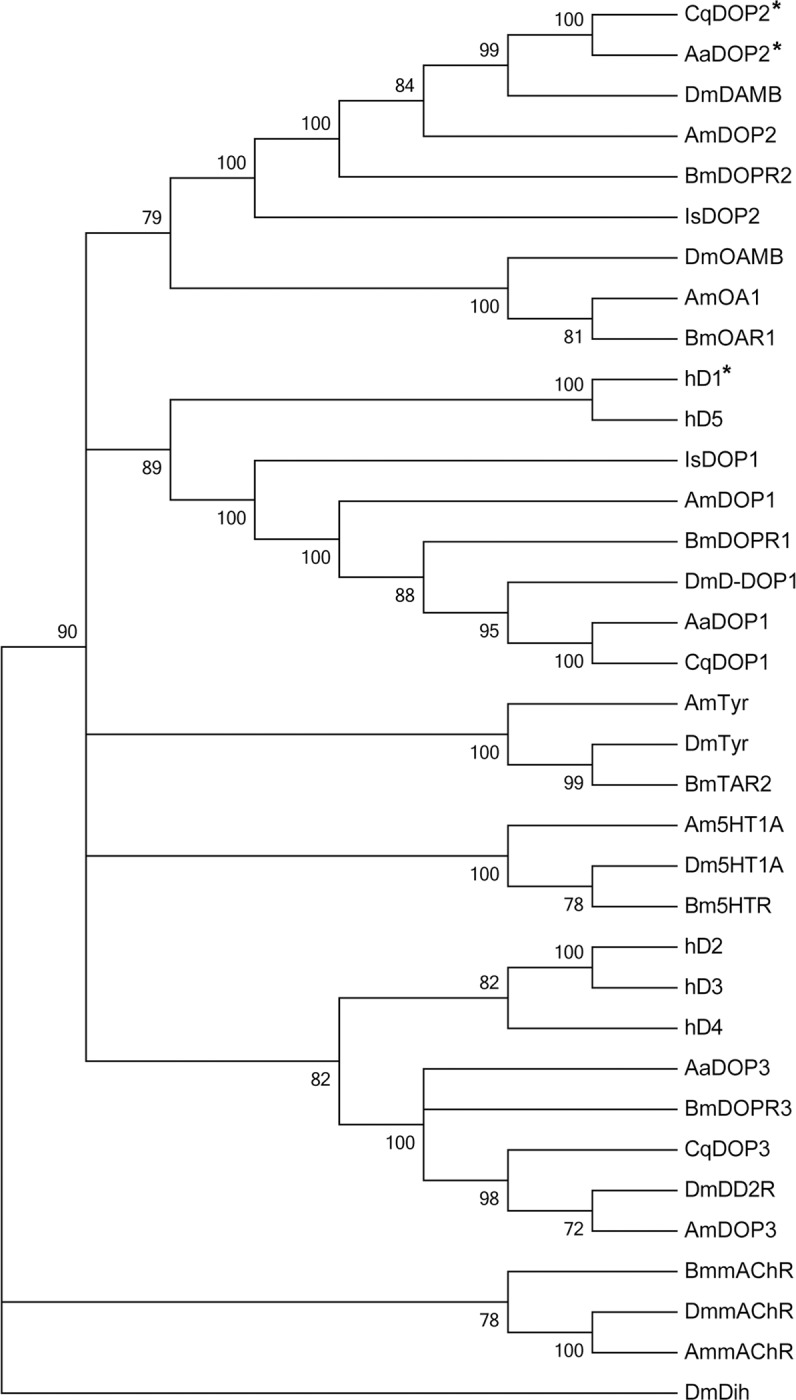
Neighbor-joining sequence analysis of CqDOP2, AaDOP2 and representative biogenic amine receptors.Abbreviations and NCBI accession numbers of species indicated are as follows: Aedes aegypti = Aa; AaDOP1 = D1-like dopamine receptor 1 (JN043502); AaDOP2 = D1-like dopamine receptor 2 (JN043503); AaDOP3 = D2-like dopamine receptor (XM_001648573); Culex quinquefasciatus = Cq; CqDOP1 = D1-like dopamine receptor 1 (XM_001842358); CqDOP2 = D1-like dopamine receptor 2 (KM262648); CqDOP3 = D2-like dopamine receptor (XM_001865540); Ixodes scapularis = Is; IsDOP1 = D1-like dopamine receptor 1 (ISCW001496); IsDOP2 = D1-like dopamine receptor 2 (ISCW008775); D. melanogaster = Dm; DmD-Dop1 = D1-like dopamine receptor (P41596); DmDAMB = D1-like dopamine receptor (DopR99B/DAMB: AAC47161); DmDD2R = D2-like dopamine receptor (DD2R-606: AAN15955); DmDih = diuretic hormone 44 receptor 1 (NP_610960.1); DmmAChR = muscarinic acetylcholine receptor (AAA28676); DmOAMB = octopamine receptor in mushroom bodies, isoform A (NP_732541); Dm5HT1A = serotonin receptor 1A, isoform A (AAM68432); DmTyr = tyramine receptor (CG7431: NP_650652); Apis mellifera = Am; AmDOP1 = D1-like dopamine receptor (NP_001011595); AmDOP2 = D1-like dopamine receptor (NP_001011567); AmDOP3 = D2-like dopamine receptor (NP_001014983); AmmAChR = muscarinic acetylcholine receptor (XP_395760); AmOA1 = octopamine receptor (oar, NP_001011565); Am5HT1A = serotonin receptor (NP_001164579); AmTyr = tyramine receptor (NP_001032395.1); Bombyx mori = Bm; BmDOPR1 = D1-like dopamine receptor (AB162715); BmDOPR2 = D1-like dopamine receptor (AB162716); BmDOP3 = D2-like dopamine receptor (XM_004925908); BmmAChR = muscarinic acetylcholine receptor (XM_004922849); BmOAR1 = octopamine receptor (NM_001098278); Bm5HTR = serotonin receptor (X95604); BmTAR2 = tyramine receptor (NM_001171178); Homo sapiens = h; hD1, D1-like dopamine receptor (D(1A), NP_000785); hD2 = D2-like dopamine receptor (D(2), NP_000786); hD3 = D2-like dopamine receptor (D(3), NP_000787); hD4 = D2-like dopamine receptor (D(4), NP_000788); hD5 = D1-like dopamine receptor (D(1B)/D5,NP_000789). * Indicates receptors pharmacologically characterized in the current study.